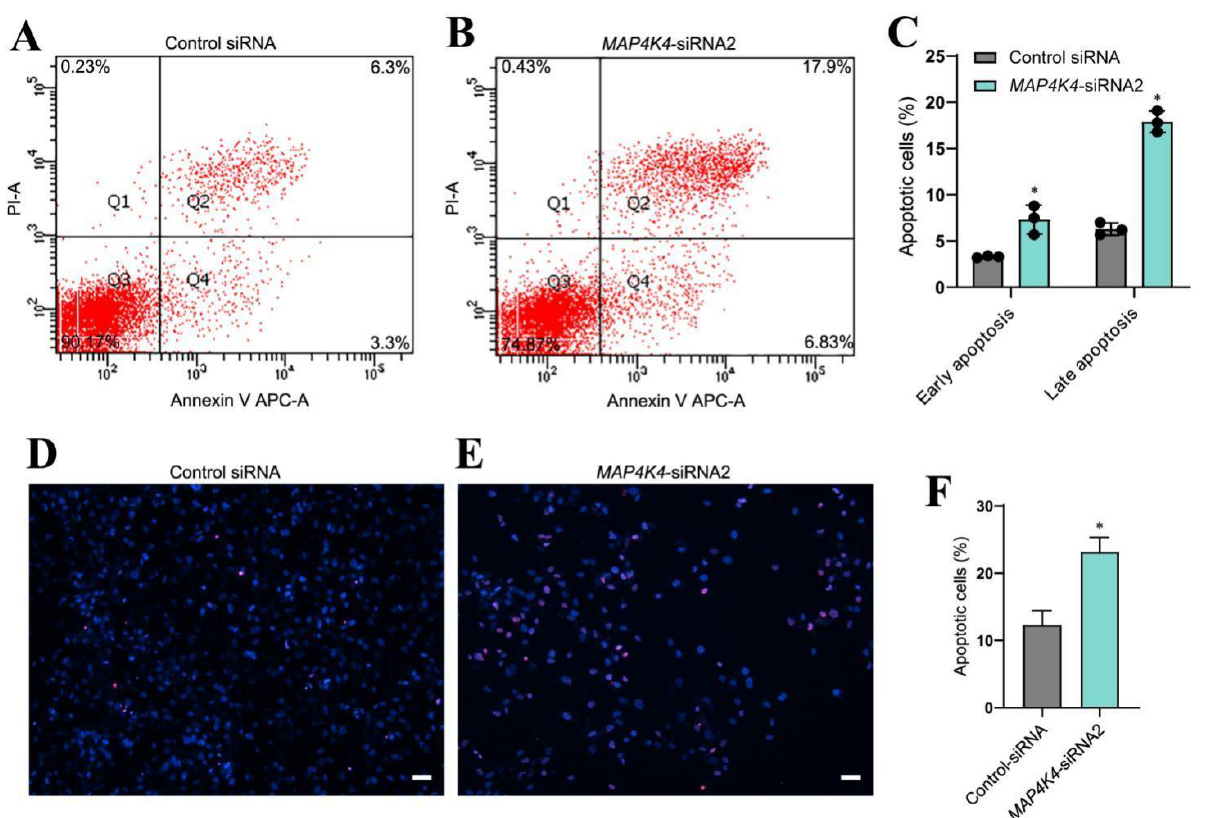
Figure 3. The effect of MAP4K4 knockdown on the apoptosis of the human SSC line. ( A – C ) Flow cytometric and APC Annexin V analysis showed the percentages of apoptosis in human SSC line after transfection with control siRNA and MAP4K4-siRNA2. ( D – F ) TUNEL assays displayed the percentages of TUNEL + cells in human SSC line with transfection of control siRNA and MAP4K4- siRNA2. Scale bars in C: 50 μm. * indicate p < 0.05.